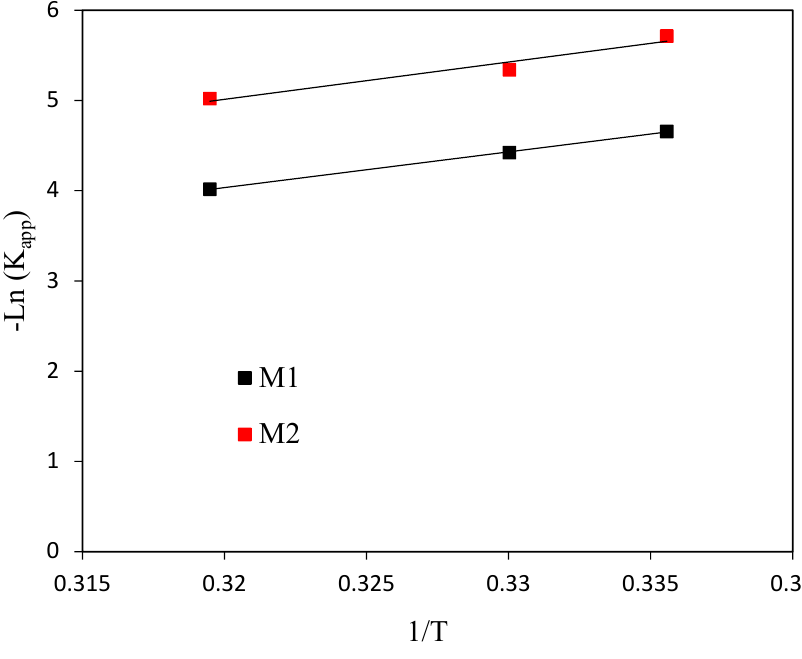
Figure 11. The plots of ln ( k app ) versus 1/ T , ( T is the temperature). Table 4. Degradation efficiency through five consecutive catalysts reuse cycles.